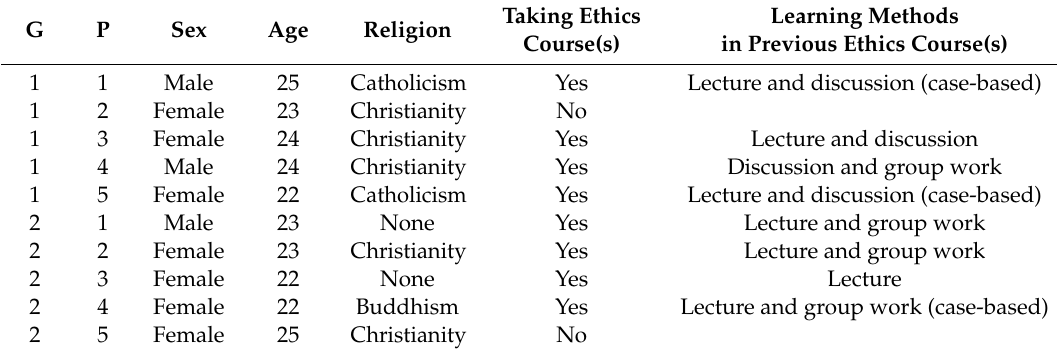
Table 2. Participants’ demographic characteristics.